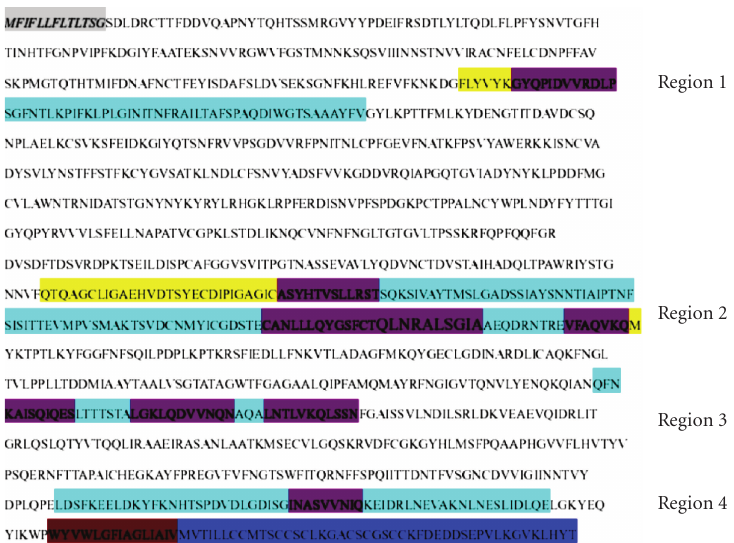
Figure 1: Sequence analysis of S protein. Putative S protein amino acid sequence was analyzed to find immunogenic regions (yellow regions) and pathogenic regions (regions shared sequence homology with human proteins, blue regions). Purple regions are both immunogenic and pathogenic regions. The grey region is the leader sequence and the brown region is the transmembrane region.